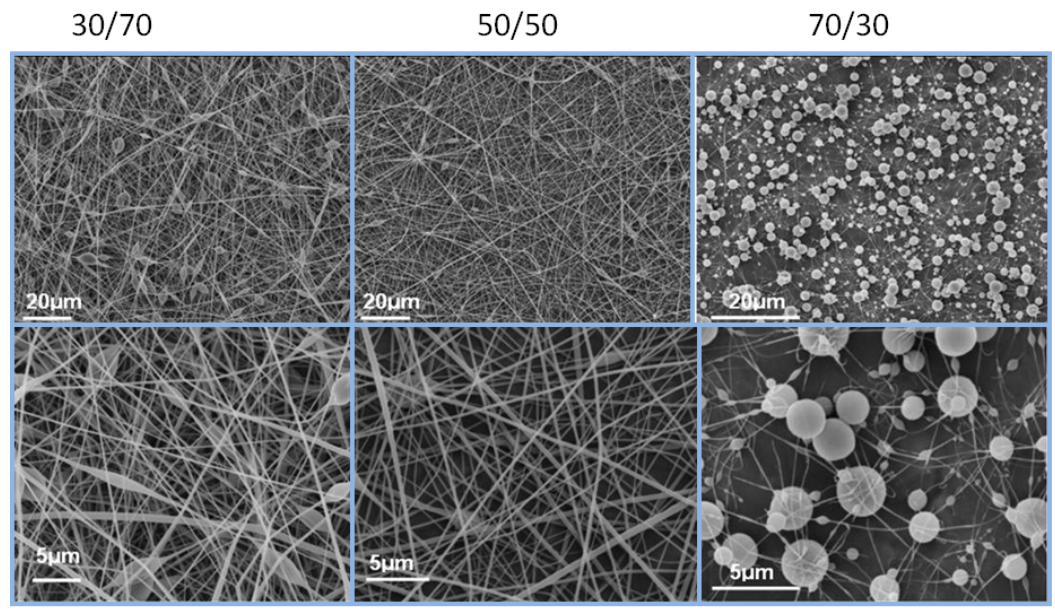
Figure 2. Effect of dimethylformamide (DMF)/tetrahydrofuran (THF) solvent volume ratios on the morphology of the electrospun phenoxy at a polymer concentration of 15% (increasing magnification from top to